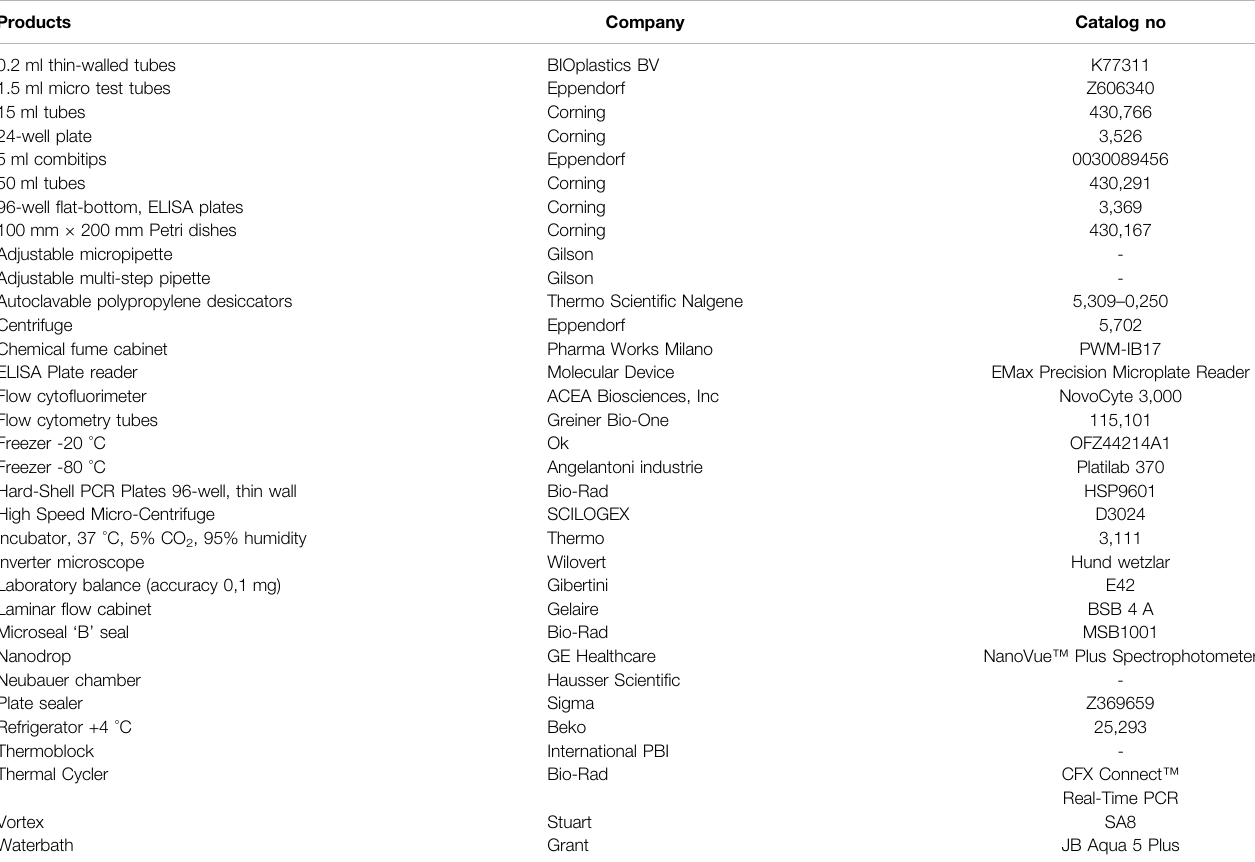
TABLE 1 | Products.